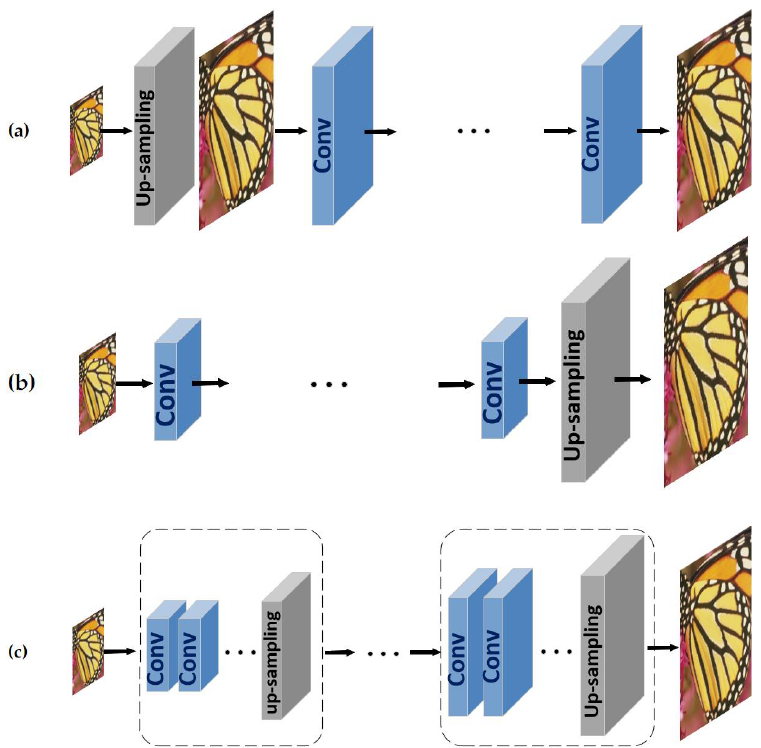
Figure 1. ( a ) Pre-upsampling, ( b ) Post-upsampling, and ( c ) Progressive upsampling